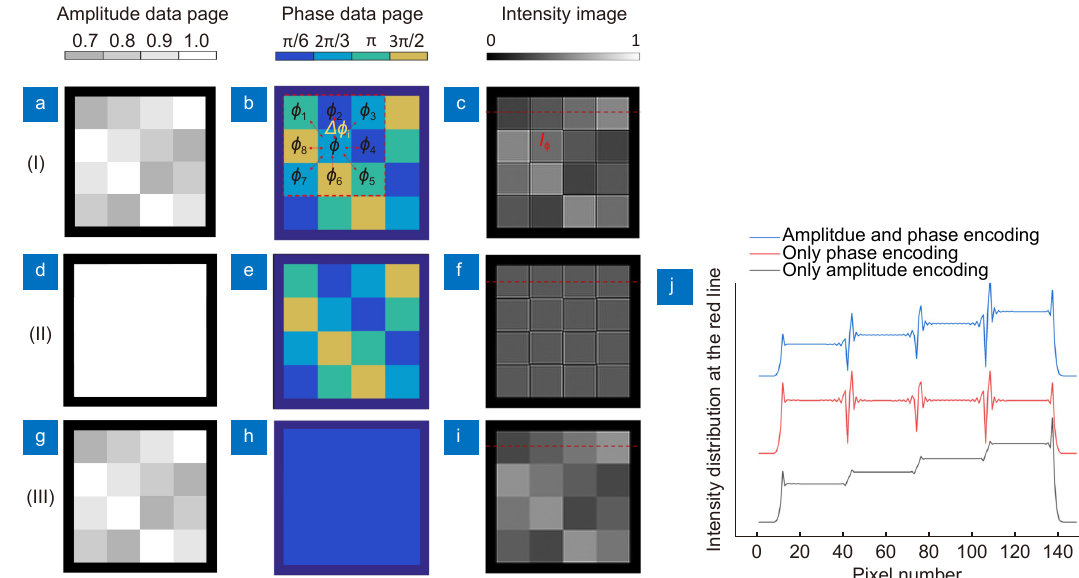
Fig. 3 | Complex amplitude encoding modes and the corresponding diffraction features. ( a ) Four-level amplitude data page. ( b ) Four-level phase data page. ( c ) Diffraction intensity image of the complex-amplitude data page ( z = 2 mm). ( d ) Uniform amplitude with no encoding. ( e ) Four-level phase data page. ( f ) Diffraction pattern of the phase-only data page ( z = 2 mm). ( g ) Four-level amplitude data page. ( h ) Uniform phase without encoding. ( i ) Diffraction pattern of the amplitude-only data page ( z = 2 mm). ( j ) Intensity distribution of the three intensity images in the same horizontal section.